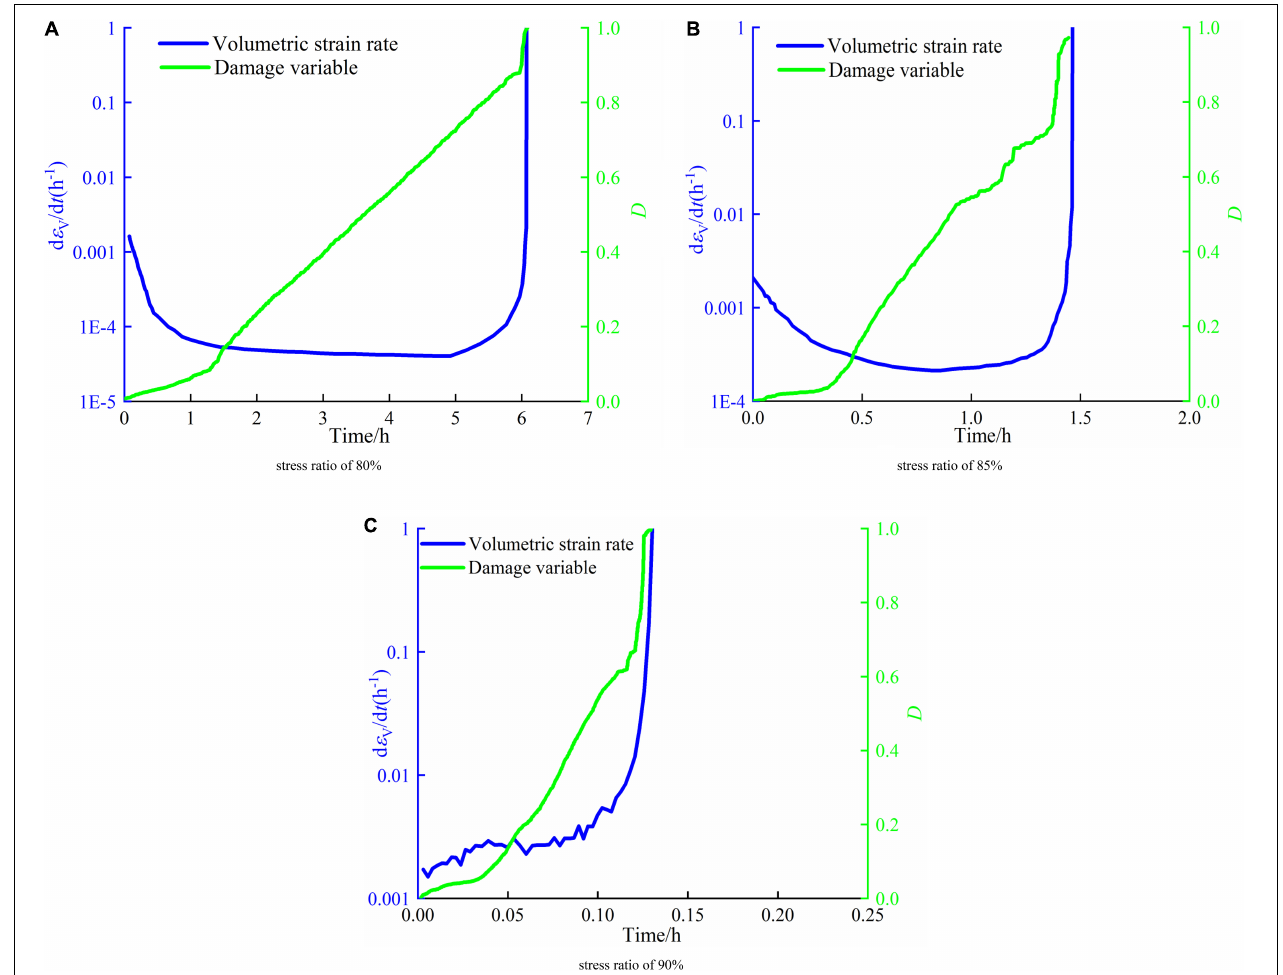
FIGURE 10 | Damage variable and volumetric strain rates under the confining pressure of 2.5 MPa. (A) Stress ratio of 80%. (B) Stress ratio of 85%. (C) Stress ratio of 90%.